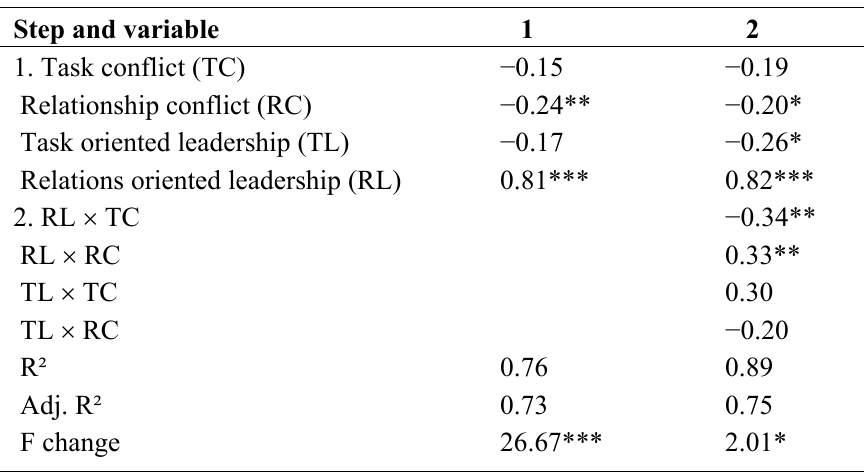
Table 3. Regression analysis of teamwork quality by type of intra-group conflict and leadership